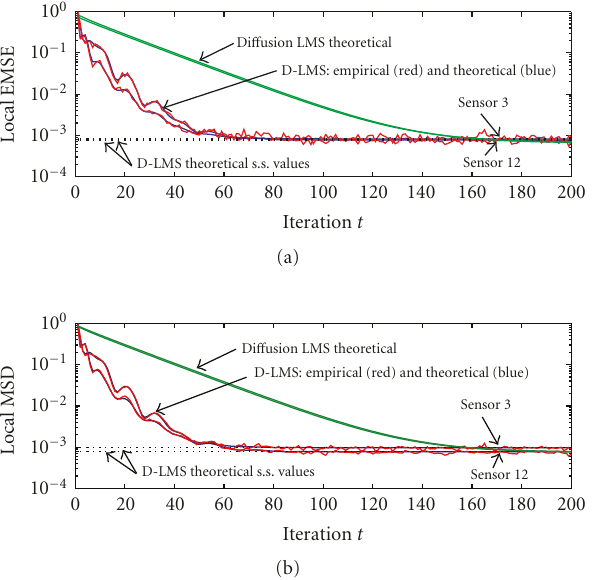
Figure 5: Local performance evaluation for a time-varying parame- ter: empirical and theoretical curves for sensors 3 and 12, both with and without communication noise.